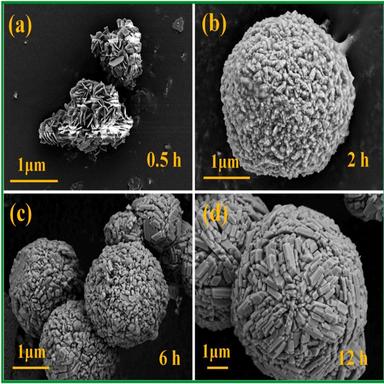
(a-c) FE-SEM images for the shape-evolution process of Fe3S4(150 °C) at different reaction times: (a) 0.5 h, (b) 2 h, (c) 6 h and (d) 12 h.